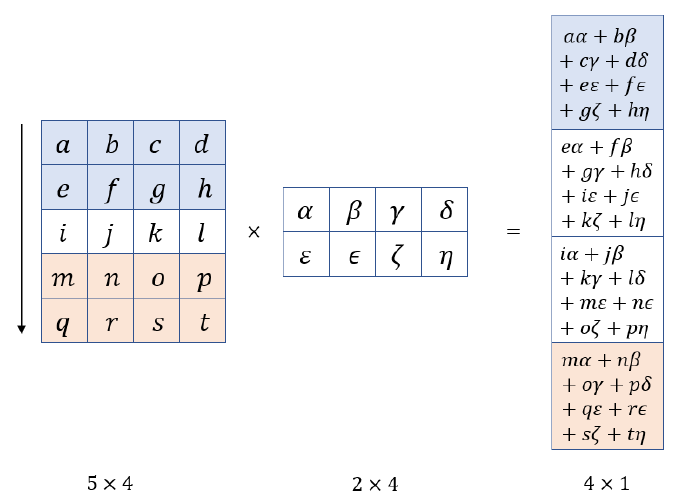
Figure 2. One-dimensional convolution operation process.